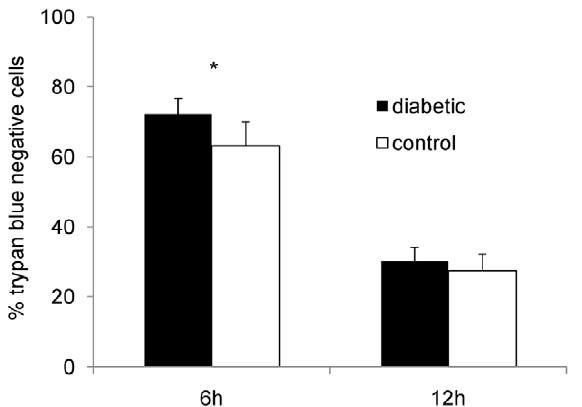
Figure 3. Viability of neutrophils isolated from the peritoneal cavities of diabetic and nondiabetic mice infected for 18 h with S.aureus PS80. Neutrophils were incubated ex vivo for 6 or 12 h, and the percentage of viable (trypan blue negative) neutrophils was measured. Mean percentages 6 SEM from five independent experi- ments are depicted; * indicates P , 0.05.